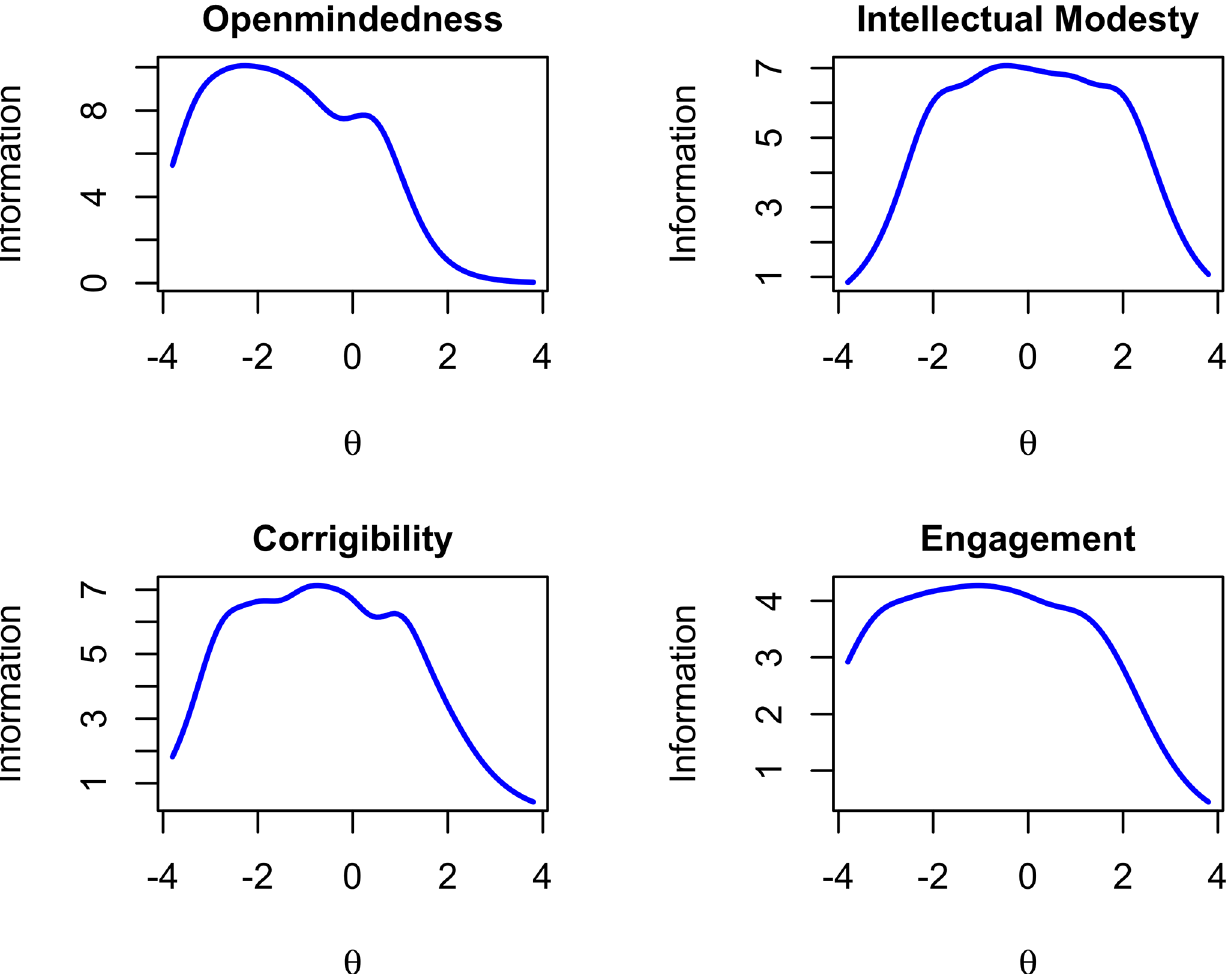
Fig 5. Intellectual humility item response analysis. Test information functions for subscalesof the Intellectual Humility scale.